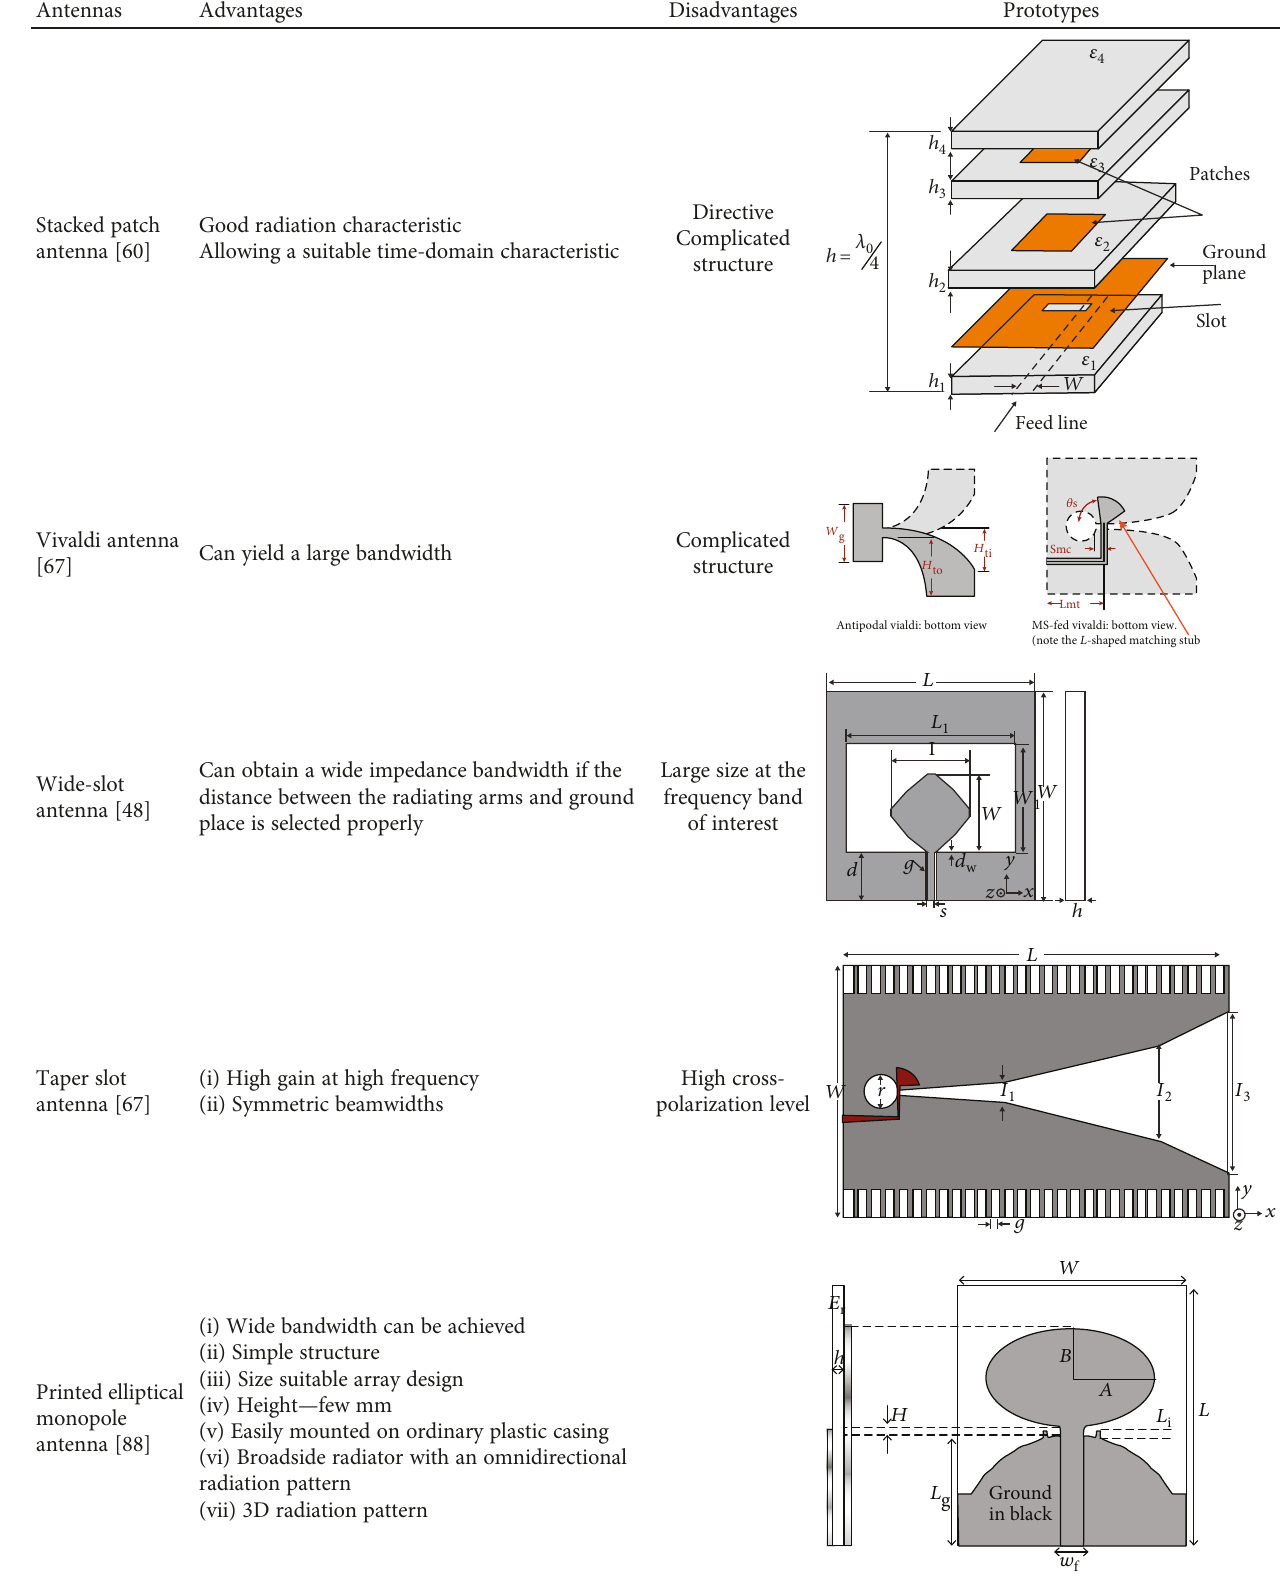
Table 3: A brief comparison of applied UWB antennas for communication